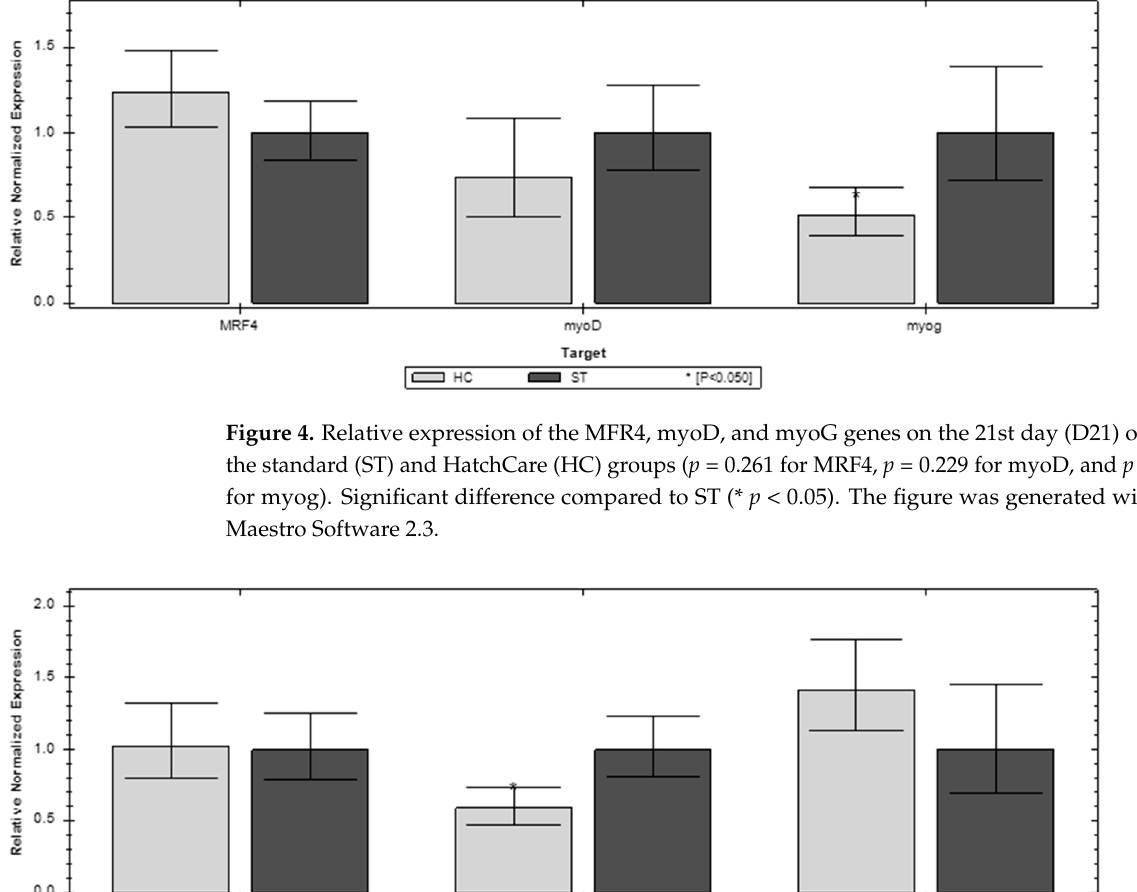
Figure 3. Relative expression of the MFR4, myoD, and myoG genes on day 7 (D7) of life in the standard (ST) and HatchCare (HC) groups ( p = 0.041 for MRF4, p = 0.129 for myoD, and p = 0.049 for myog). Significant difference compared to ST (* p < 0.05). The figure was generated with CFX Maestro Software 2.3.